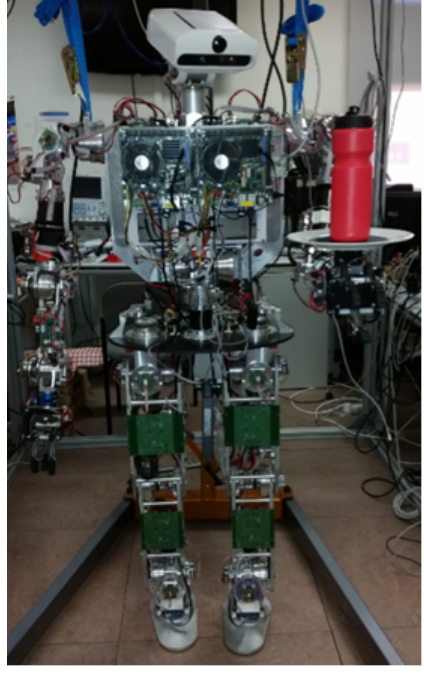
Figure 1. Humanoid robot TEO (Task Environment Operator) transporting an